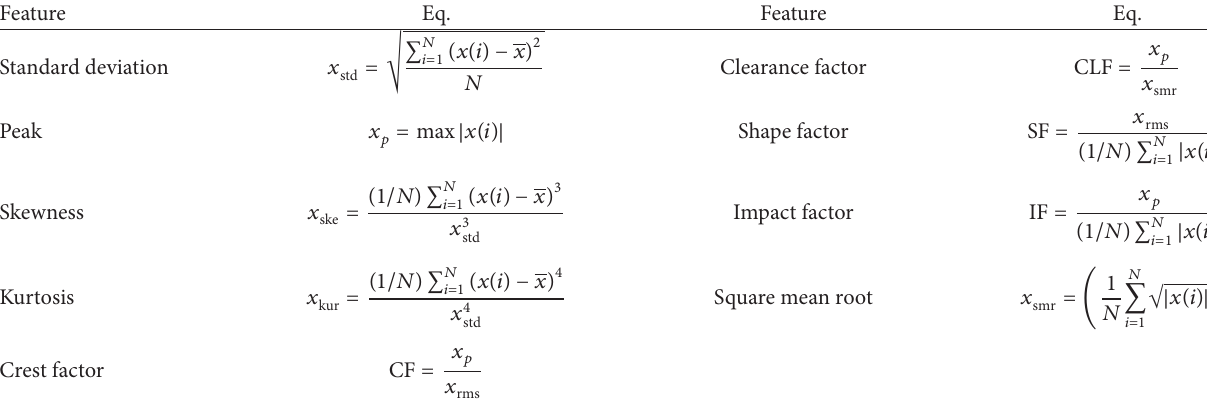
Table 3: Time-domain statistical